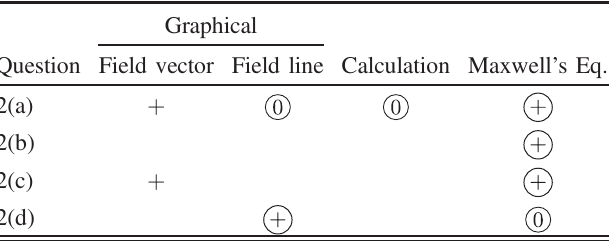
TABLE II. Analysis of responses given by student A regarding the divergence of electric fields [questions 2(a) – 2(d)]. Graphical